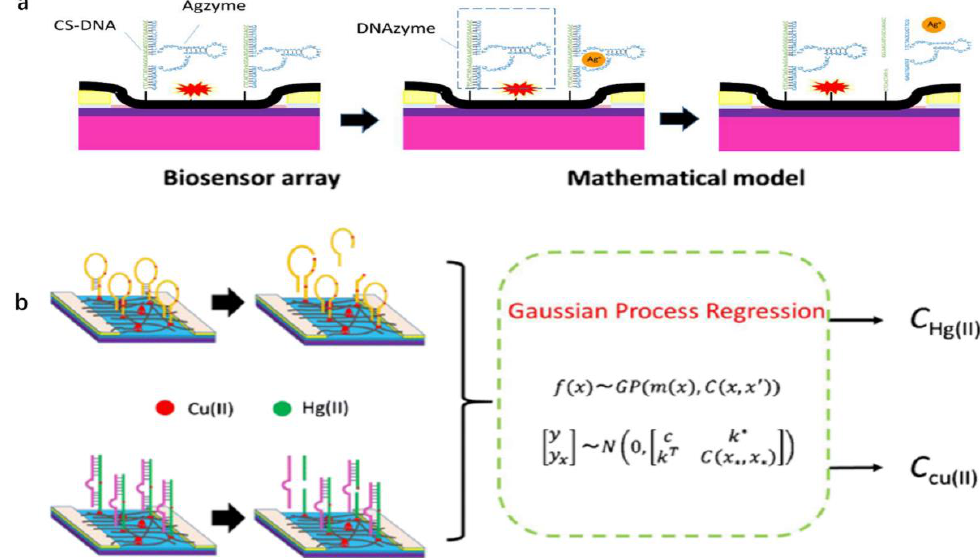
Figure 12. ( a ) DNAzyme cut its substrate chain at the RNA site in the presence of Ag + . Reproduced from Yang et al. [197] by permission of Elsevier Science Ltd.; ( b ) DNAzyme cleavage of its substrate chain at the RNA sites in the presence of Cu 2+ and Hg 2+ and the Gaussian process regression formula. Reproduced from Hui et al. [209] by permission of Elsevier Science Ltd.